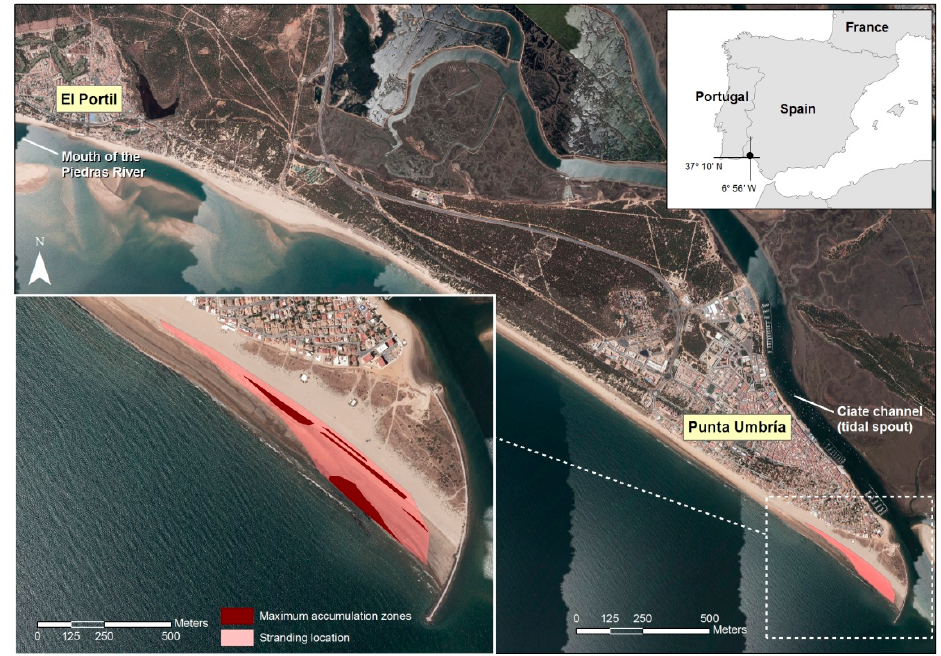
Figure 1. Punta Umbría Beach, where the mass stranding of marine organisms took place between 4th and 8th of March, 2018. The distribution of the maximum accumulations of organisms is shown in the enlarged image (2.4 ha).